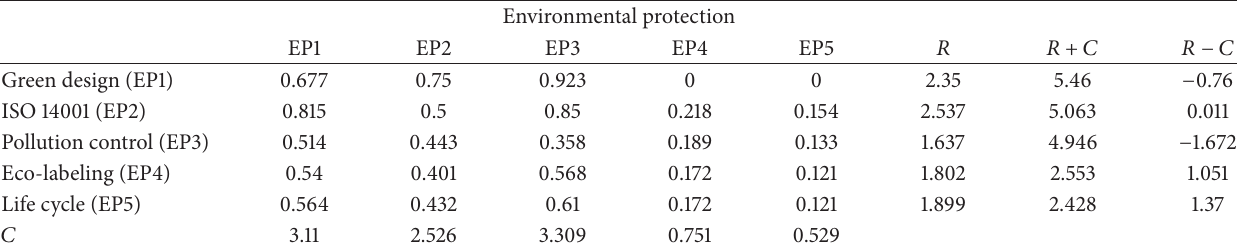
Table 5: Total-relation matrix for elements of environmental protection.